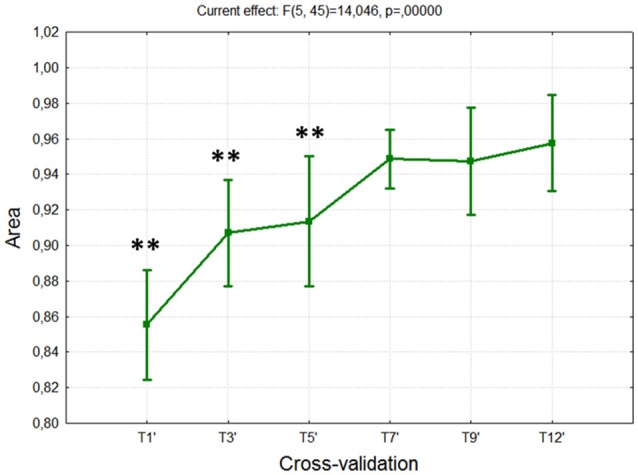
Training metric over 3 weeks of training. The proposed metric takes into account the level of task execution (performance), and both the behavioral and cognitive stabilities. The ANOVA showed significant differences (p < 10−5) among the first sessions (T1÷T7), while no differences were found among the last ones (T7÷T12). Such results indicated that the subjects reached a training stability in the session T7. “**” Means that the statistical significance level (p) is lower than 0.01. Vertical bars denote 0.95 confidence intervals (CI).